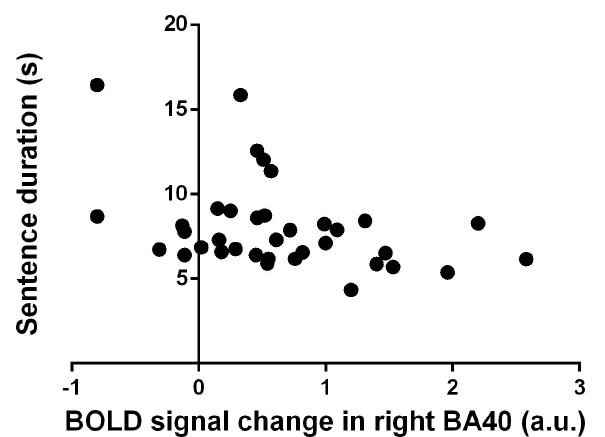
FIGURE 3 | Correlation between blood oxygenation level-dependent (BOLD) signal change in right Brodmann’s area (BA) 40 (a.u.) and sentence duration (s). Each dot refers to a single participant from both healthy controls and people with multiple sclerosis